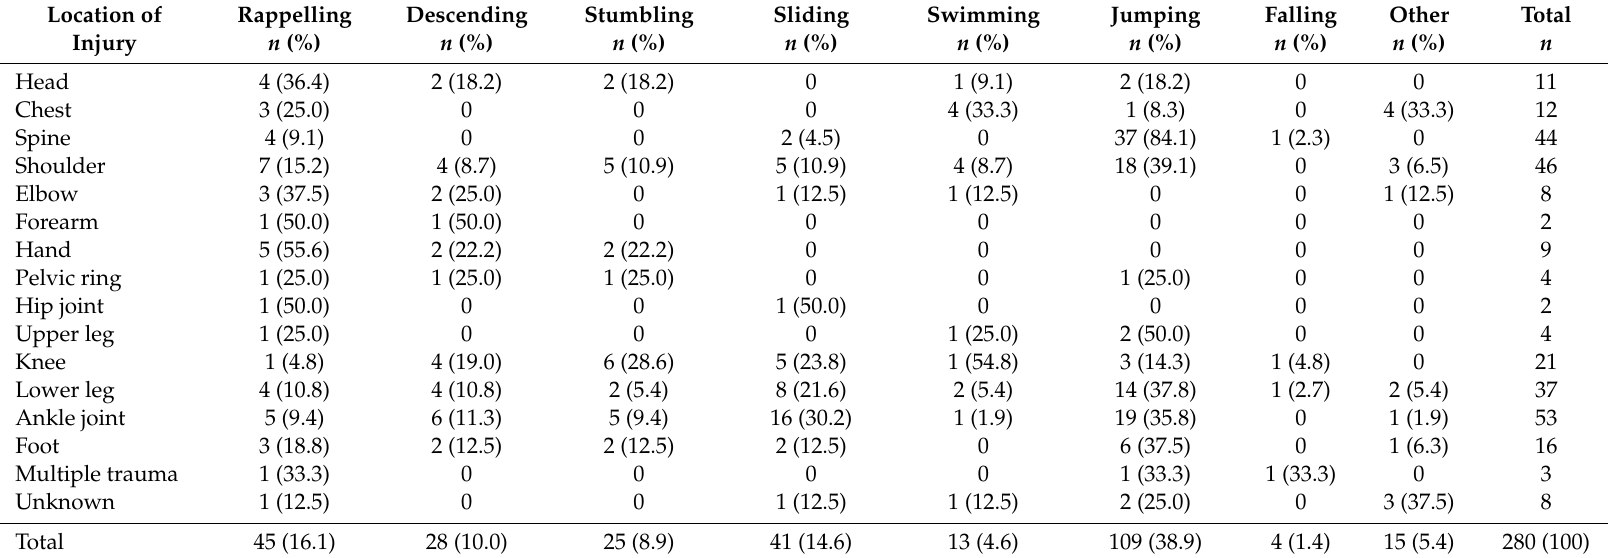
Table 3. Location of injury vs. activity in canyoning emergencies in Austria from November 1, 2005 to October 31,